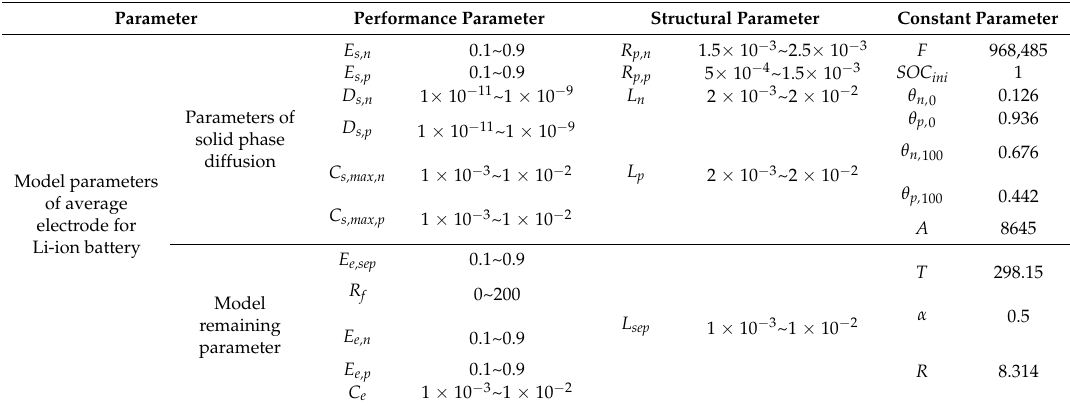
Table 2. Electrochemical model parameters of Li-ion